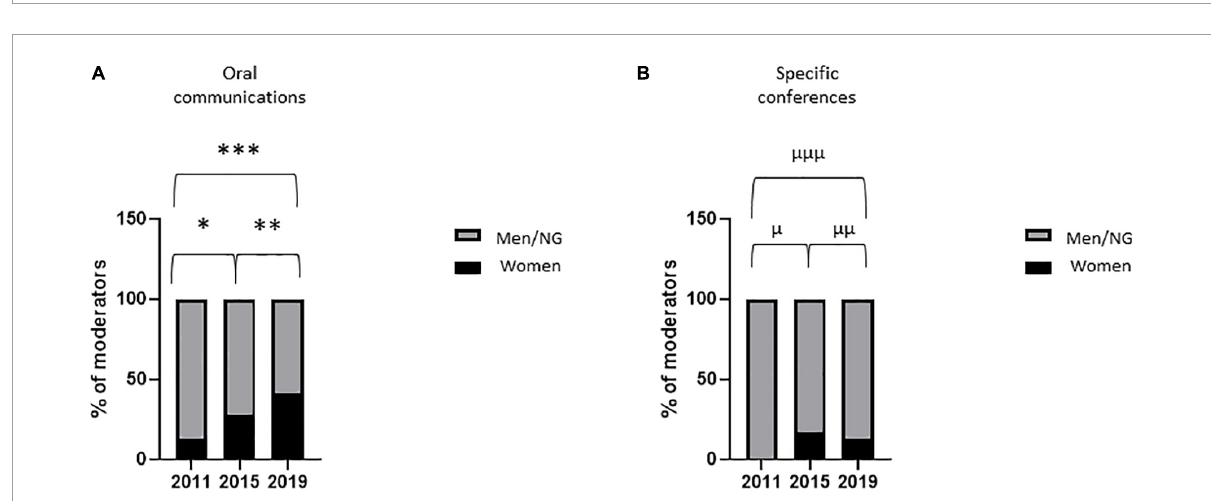
FIGURE2 Women moderators in major oral sessions. Proportion of women moderators in major oral sessions [ (A) oral communications; (B) specific conferences] during the three congresses. Variables are presented as percentages. After contingency analysis, variables were compared